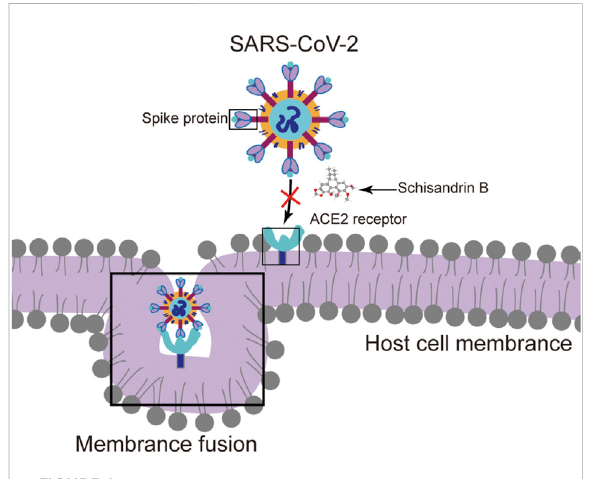
FIGURE 1 Schisandrin B (SchB) inhibits SARS-CoV-2 infection.